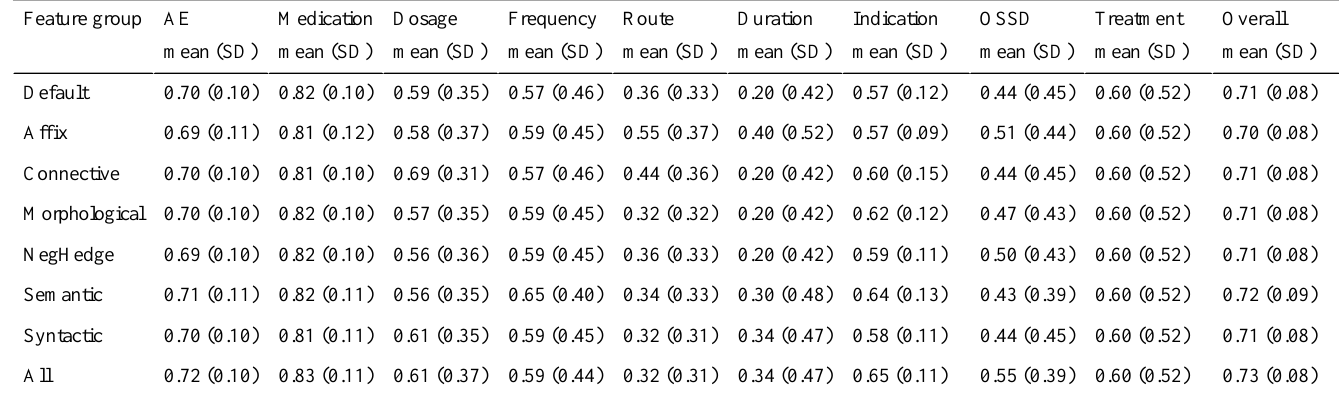
Table 3. The F1 score of different named entities with different features on Comb dataset.